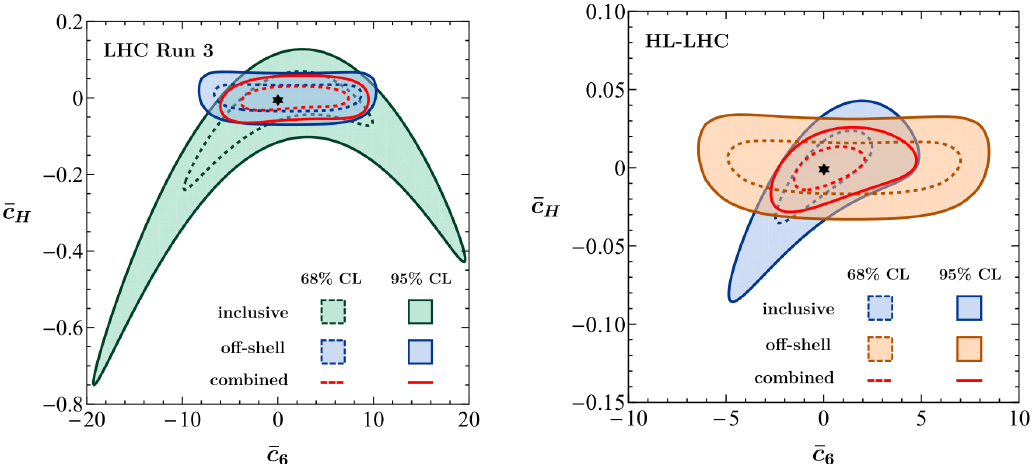
Figure 7. Projected 68% and 95% CL constraints in the ¯ c 6 – ¯ c H plane for the LHC Run 3 (left) and HL-LHC (right) assuming integrated luminosities of 300 fb − 1 and 3 ab − 1 , respectively, and pp √ collisions at s = 14 TeV . The constraints from inclusive single-Higgs probes (left: green regions, right: blue regions) are compared to the off-shell Higgs constraints (left: blue regions, right: orange regions). The combinations of all constraints are also shown as red contours. The black stars represent the SM point. See main text for further